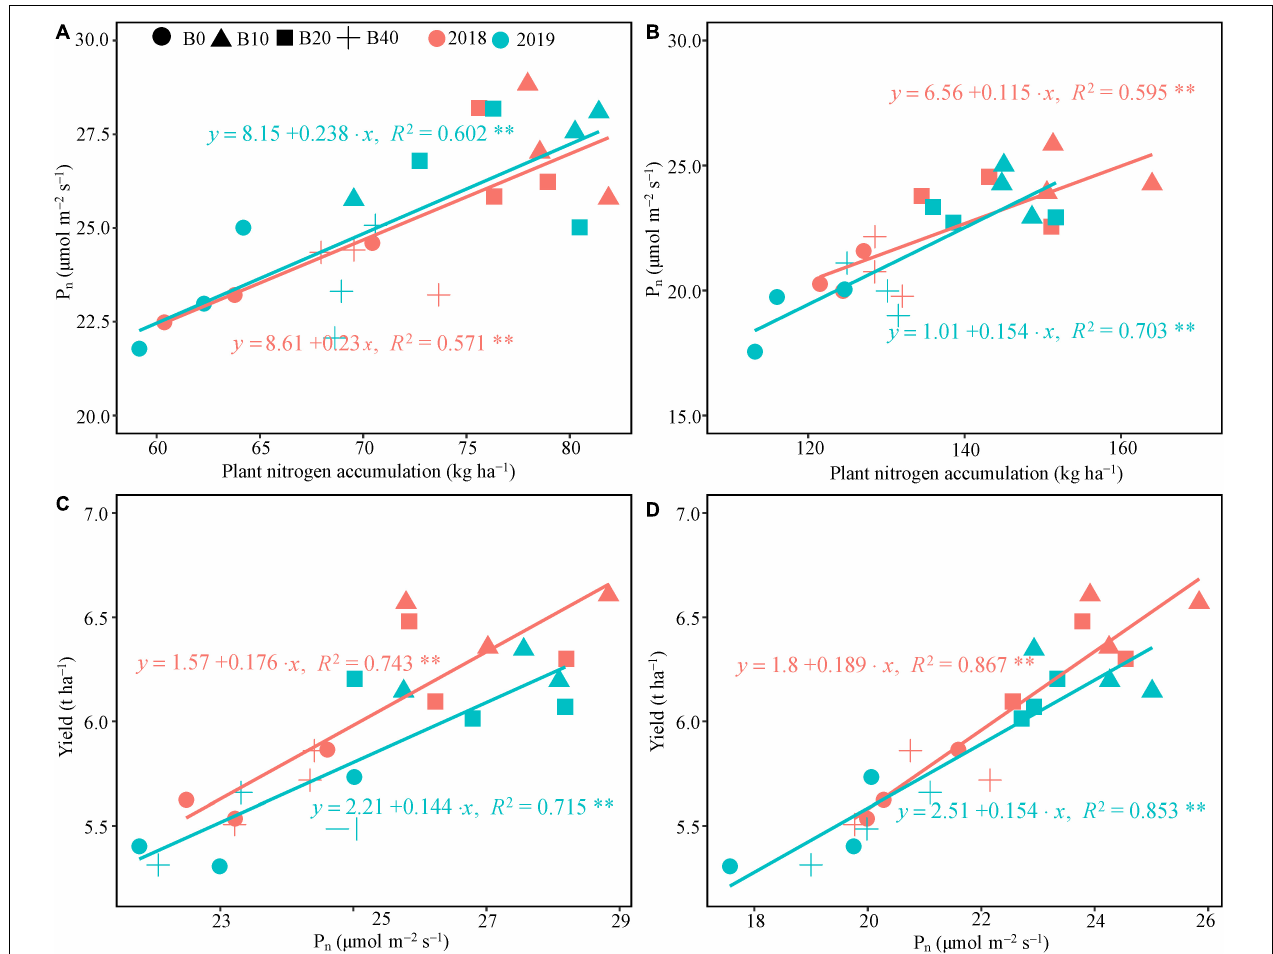
FIGURE 4 | Relationship between plant nitrogen accumulation and photosynthetic rate, and yield and photosynthetic rate at flowering (A,C) and pod set (B,D) in peanut applied with four rates of biochar in the 2018 and 2019 growing seasons. B0, B10, B20, and B40 represent biochar application rates at 0, 10, 20, and 40 t ha − 1 , respectively. P n , net photosynthetic rate; **represents significant correlations at the P < 0.01